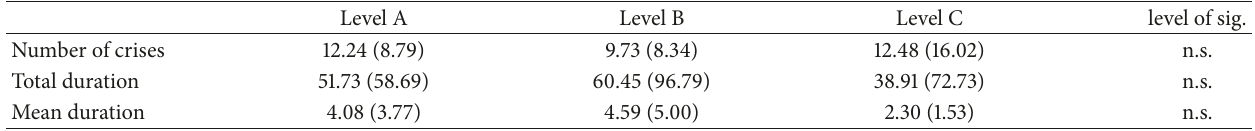
Table 1: Medium and SD value of crises number per individual in one year (i.e., frequency per individual), total duration per individual, and medium duration per individual, considered for each level of intensity (levels A, B, and C). In each cell, data are expressed as mean (SD).